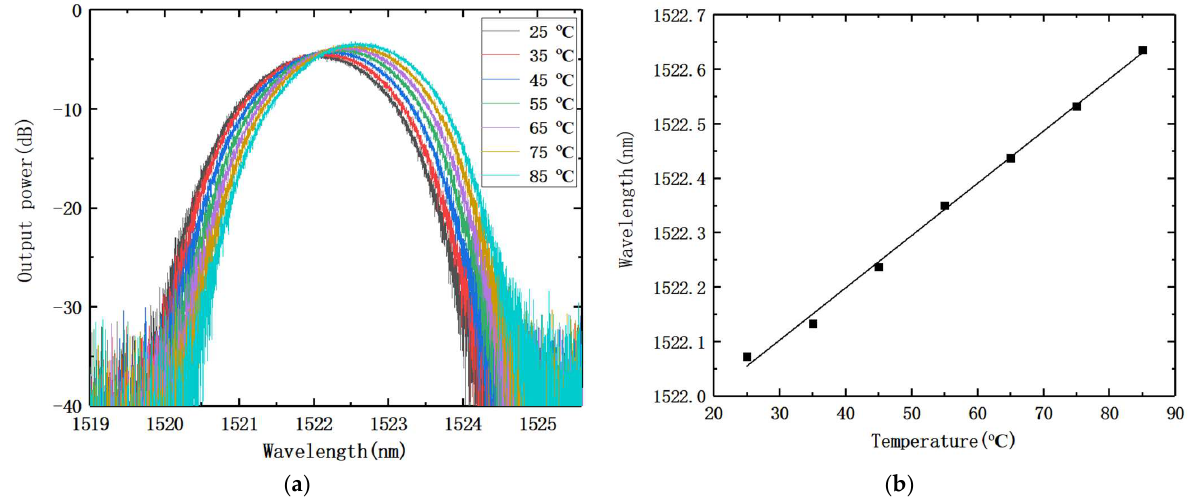
Figure 9. ( a ) Transmission spectra of channel 1 at different temperatures; ( b ) relationship between the center wavelength of channel 1 and temperature.